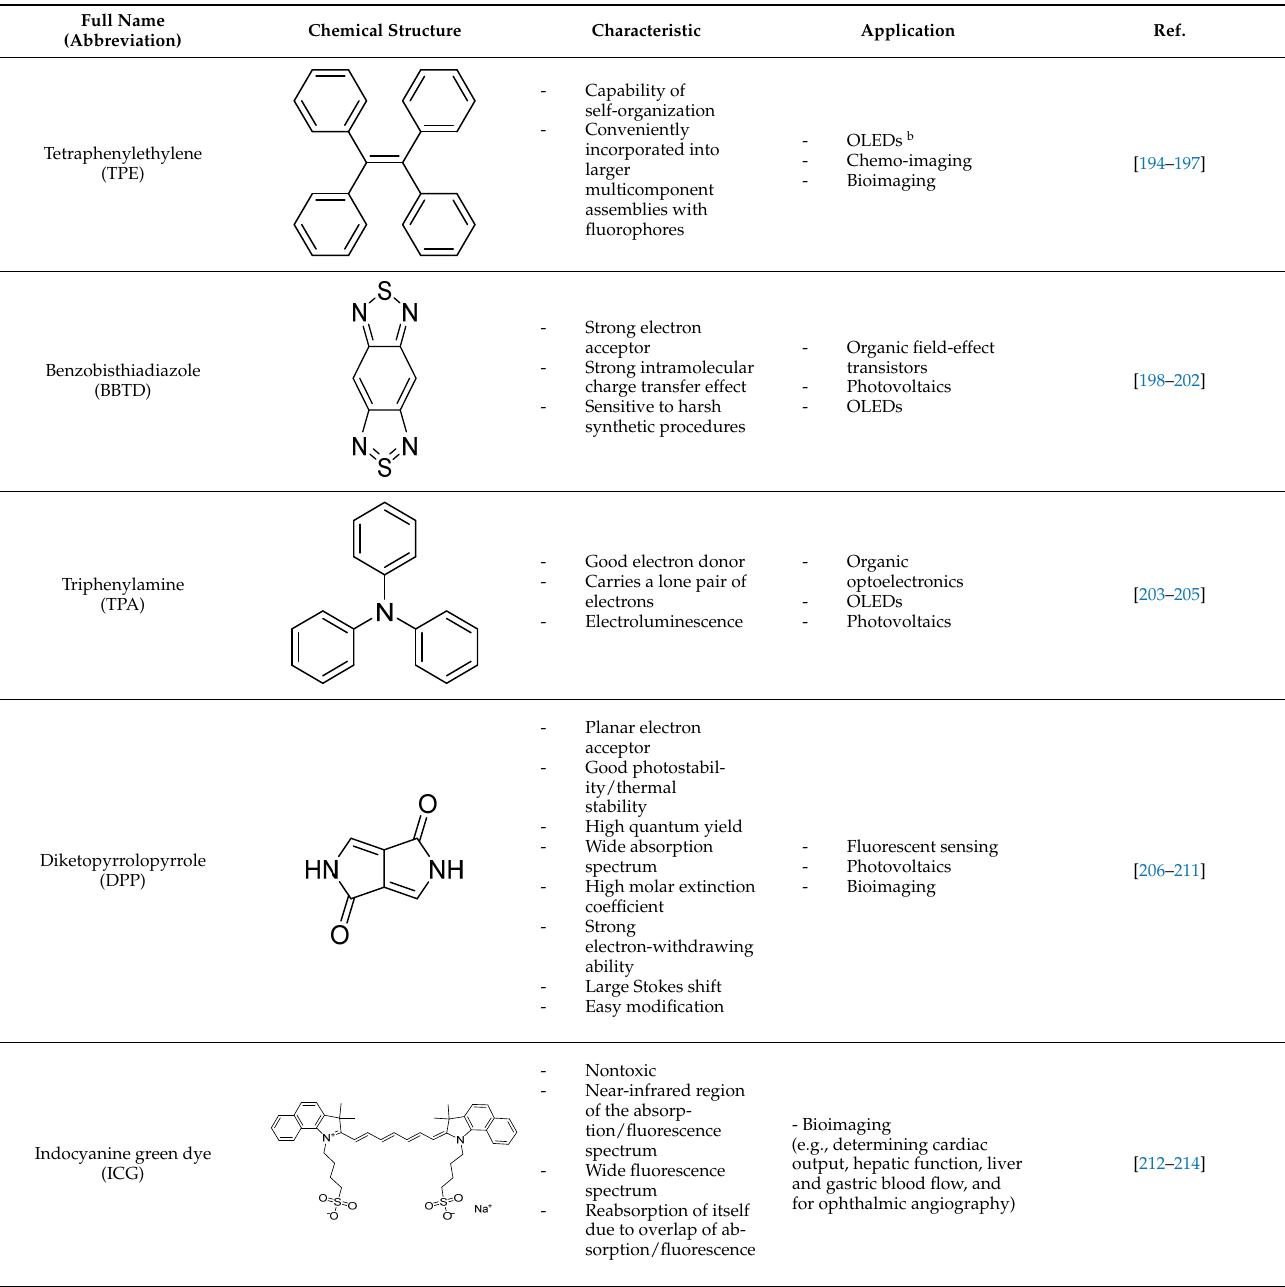
Table 2. Summary of the chemical units of small molecule-based photoluminescence probes a